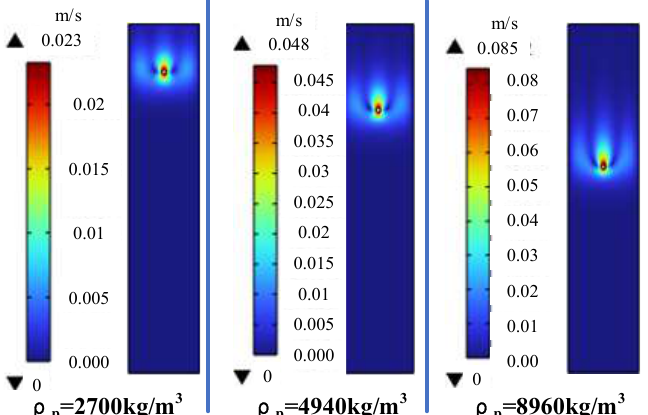
Figure 10. Velocities of 0.5 mm diameter particles with different densities at t = 0.2 s.